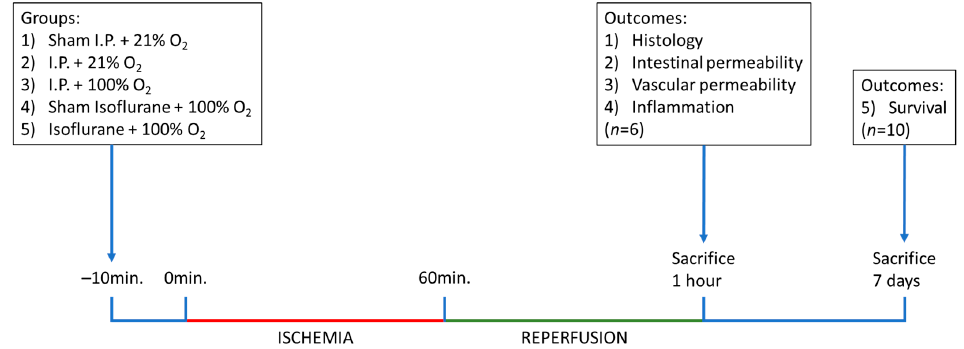
Figure 10. Timeline of the experiments, with sampling time points and explanation of the different groups. I.P.: intraperitoneal injection anesthesia; O2: oxygen.